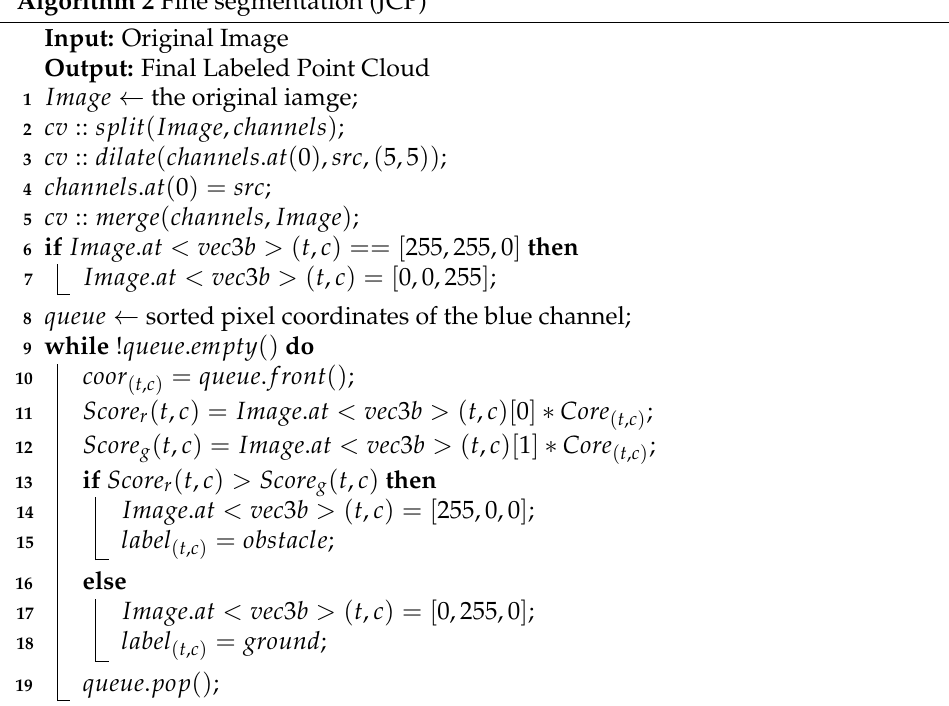
Algorithm 2 Fine segmentation